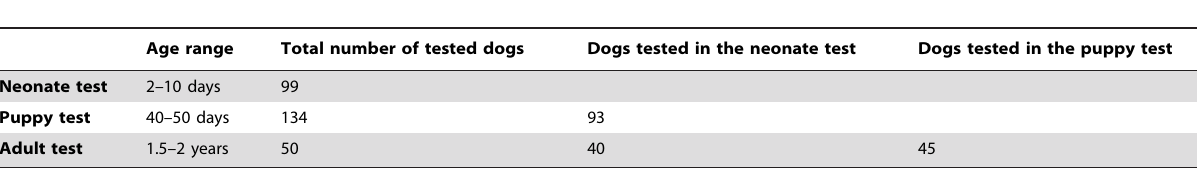
Table 1. Summary of subjects tested in the neonate test, the puppy test and the adult